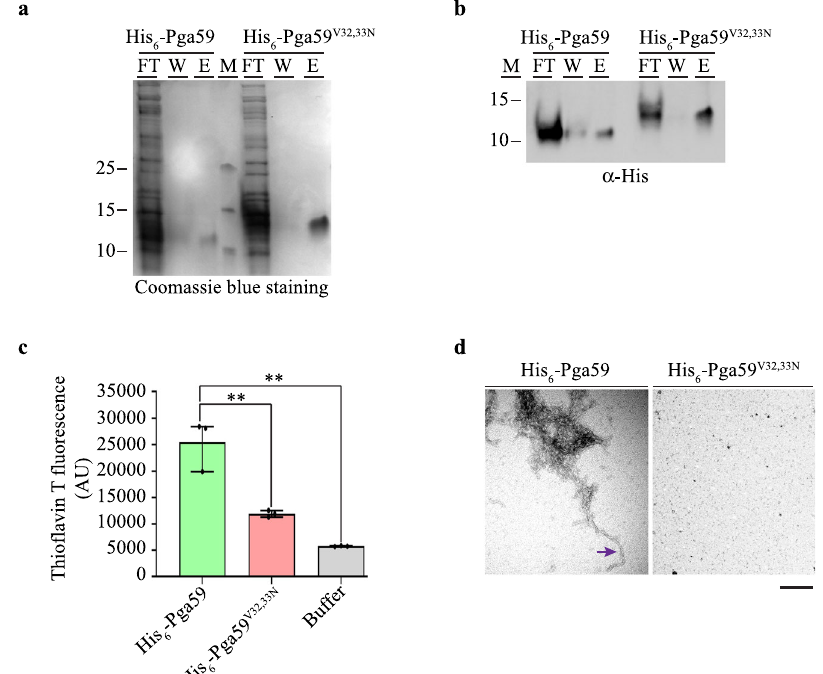
Fig. 2 rPga59 aggregates display amyloid structures properties. HIS 6 -Pga59 and HIS 6 -Pga59 V32,33N proteins were expressed in Escherichia coli and puri fi ed by af fi nity chromatography. rPga59 proteins were analysed with Coomassie blue staining ( a ) and western blot using an α -His antibody ( b ). Fractions loaded on the gel correspond to the fl ow through (FT), the wash (W) and the elution (E). (M): Molecular weight markers. Sizes are indicated on the left. c ThT fl uorescence intensity of each recombinant proteins analysed at 496 nm. The histogram shows the quanti fi cation of data from three independent experiments. Values are displayed as the averages ± SD. (**) p < 0.01. The signi fi cance of the ThT fl uorescence differences was tested using Student ’ s t -test. d Wild type (left) and mutated (right) rPga59 were negatively stained with uranyl acetate and analysed with transmission electron microscopy. An isolated amyloid fi bre formed by the WT protein is pinpointed on the micrograph with an arrow. Scale bar: 100 nm. Source data are provided as a Source Data fi